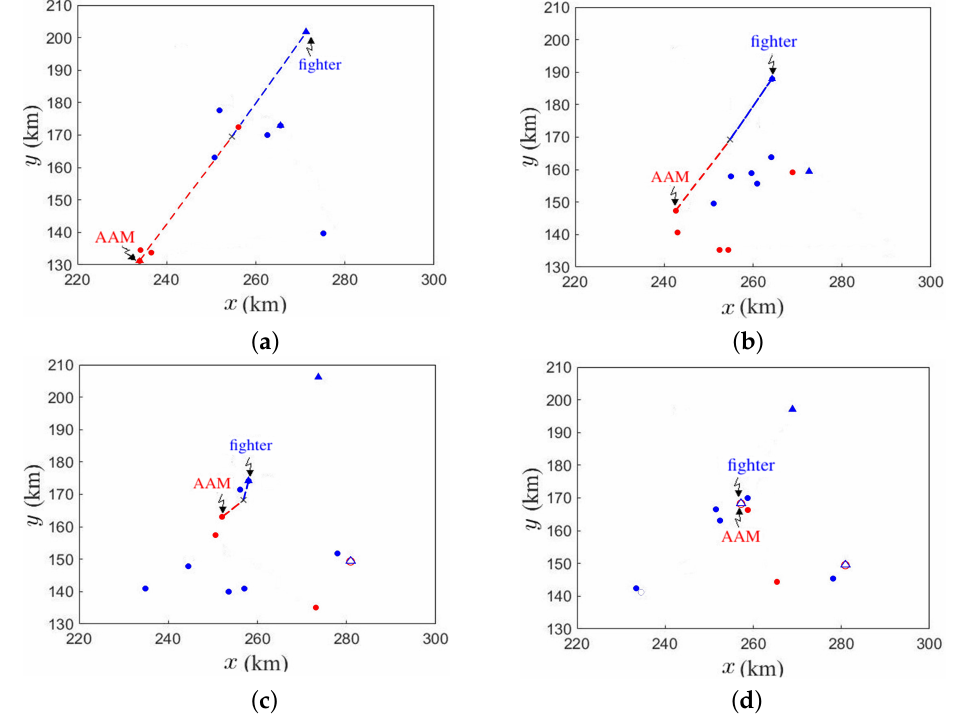
Figure 19. Specific game on A1/B1, an AAM from fleet A is intercepting a fighter from fleet B, ( a ) t = 960 s, ( b ) t = 1005 s, ( c ) t = 1050 s, ( d ) t = 1080 s; red marks for fleet A and blue marks for fleet B, blank symbols: dead assets, (cid:52) : fighter, • : AAM, × : intercept point, − − − : projected flight